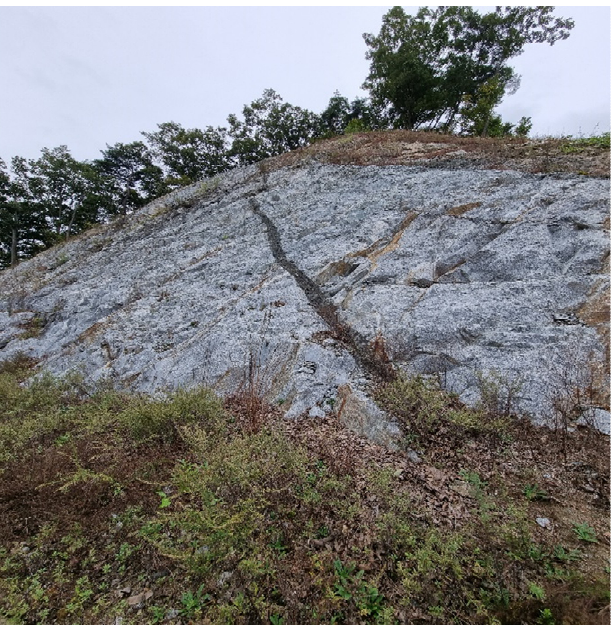
Figure 7. Single type ( artificial rock ) GGSJ.